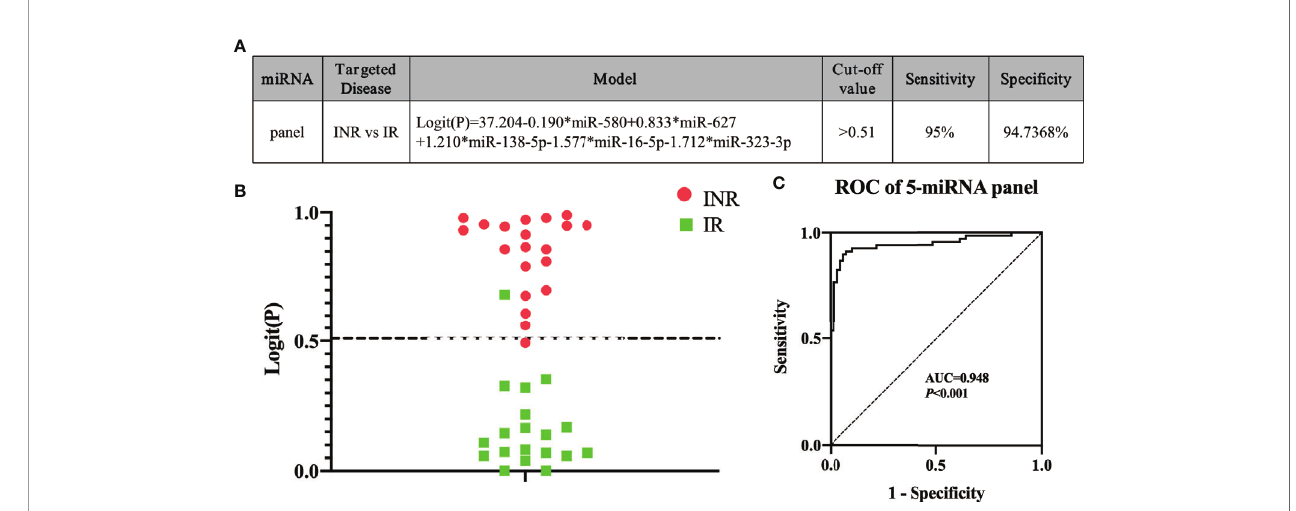
FIGURE 4 | Using our fi ve-miRNA panel to predict immune non-responders (INRs) and immune responders (IRs) in a blinded test. (A) The model and (B) the Logit (P) to identify INRs and IRs in blinded test sets (n = 49). The dashed line separates INRs and IRs by the cut-off value. (C) Analyses of receiver operating characteristic (ROC) curves of the fi ve-miRNA panel, generated by sample analysis from the mixed and blinded test